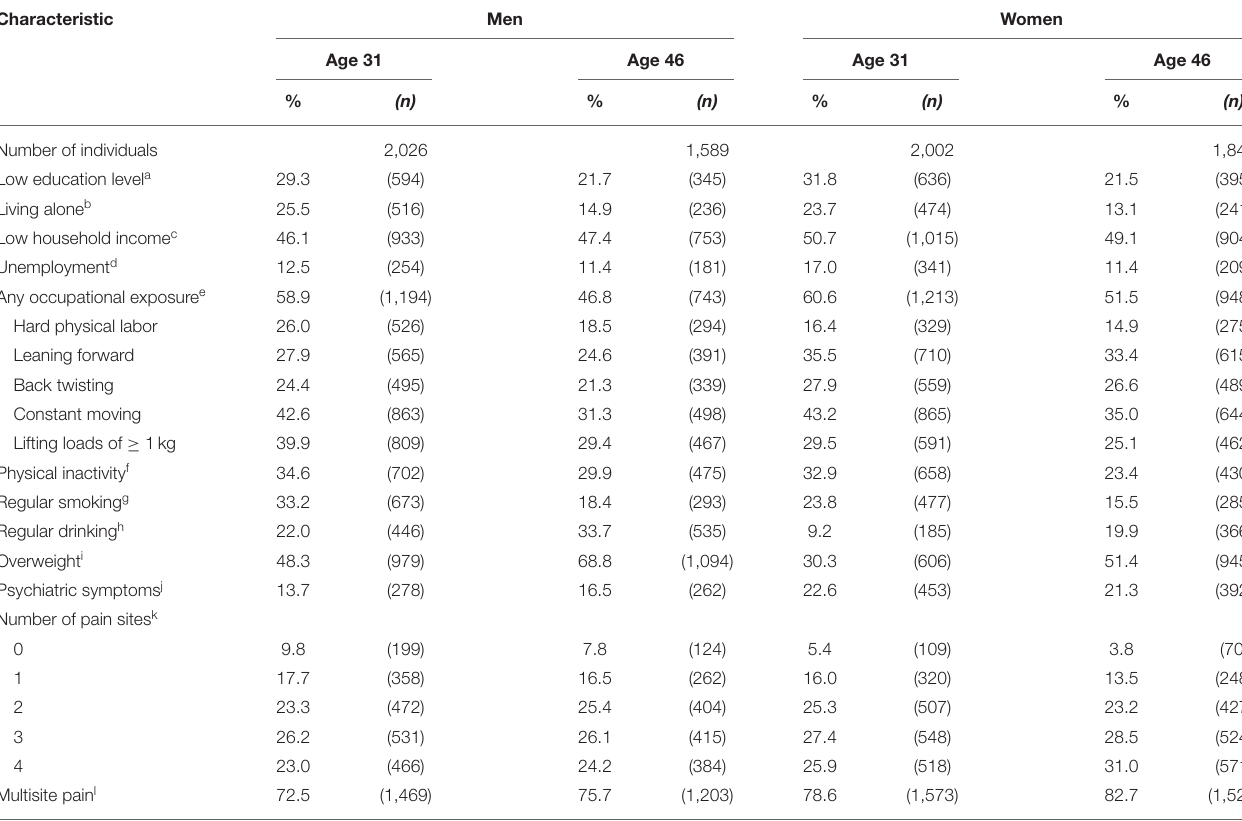
TABLE 1 | Characteristics of the study